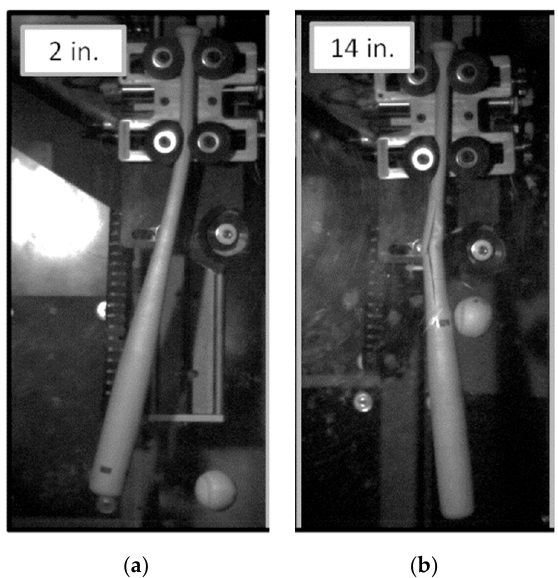
Figure 8. Two common impact locations examined for durability ( a ) Outside pitch—2.0 in (5.1 cm) and ( b ) Inside Pitch—14.0 in. (35.6 cm).